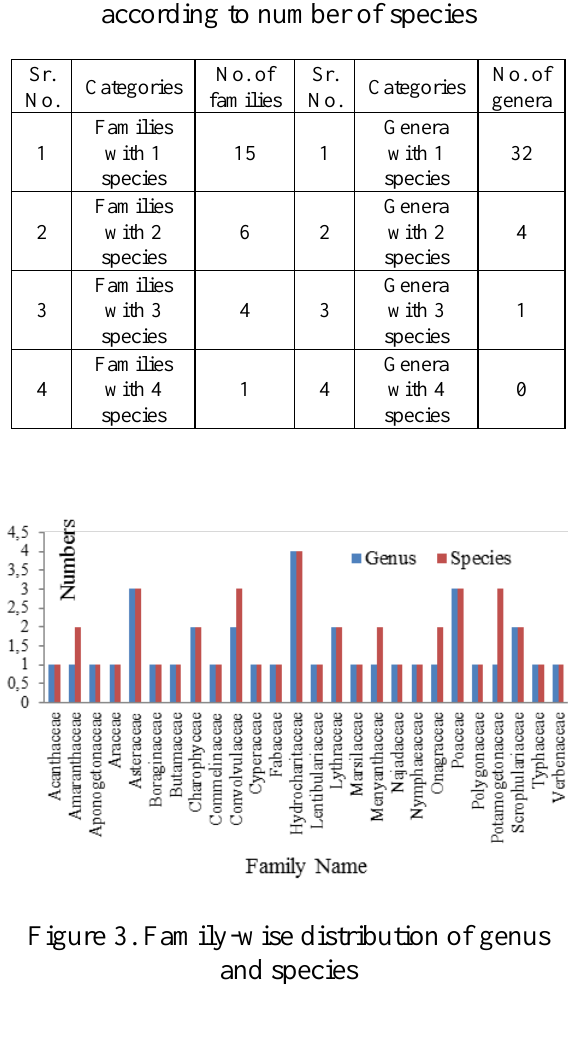
Figure 2. Distribution on the basis of plant types